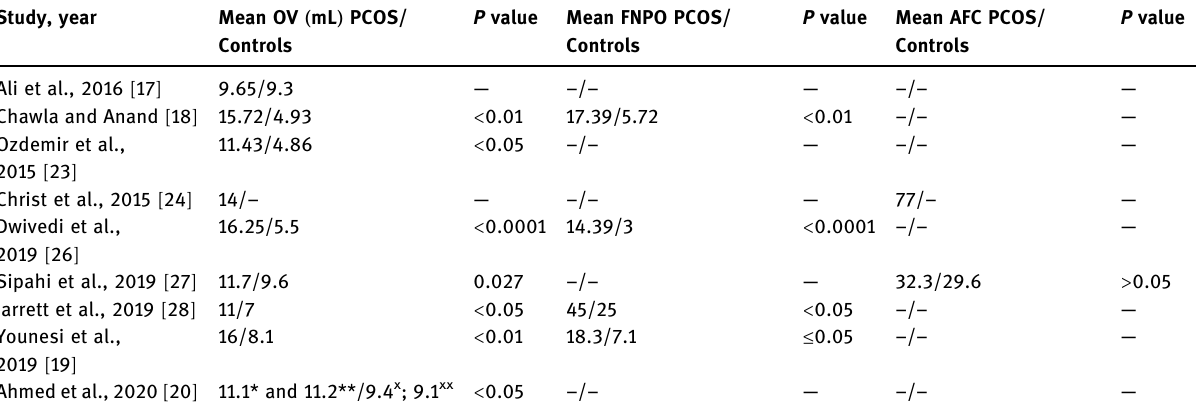
Table 3: Mean OV, FNPO, and AFC Study,